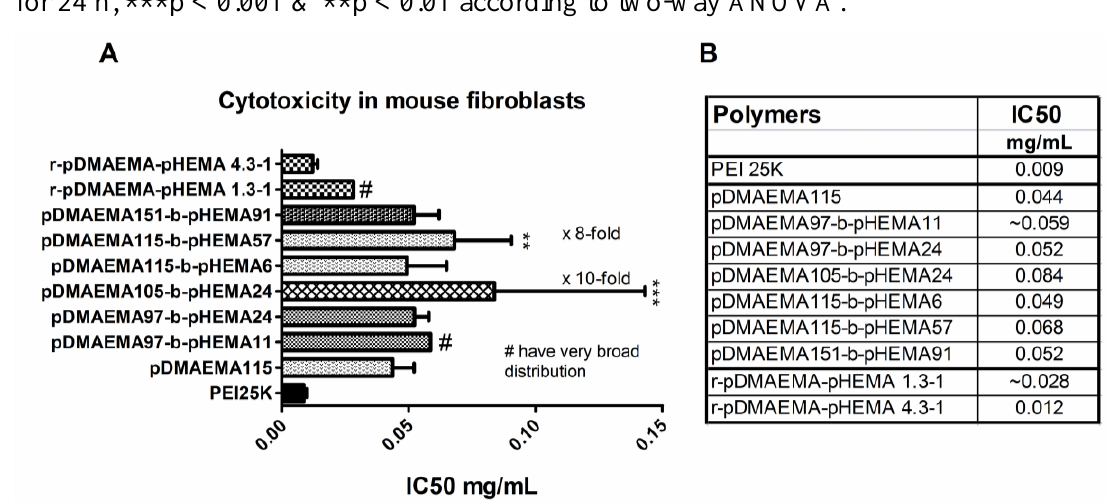
Figure 8. A , B . Cytotoxic effects of copolymers in L929 mouse fibroblasts after incubation for 24 h, ***p < 0.001 & **p < 0.01 according to two-way ANOVA.